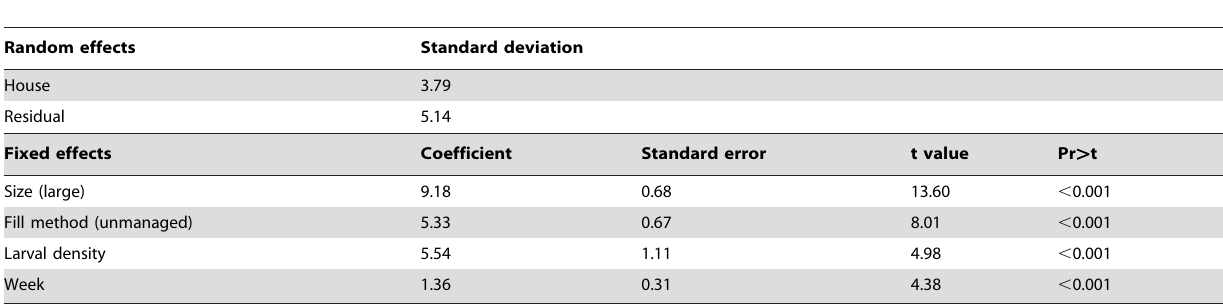
Table 1. Parameter coefficients for model predicting number of eggs laid per container per week.